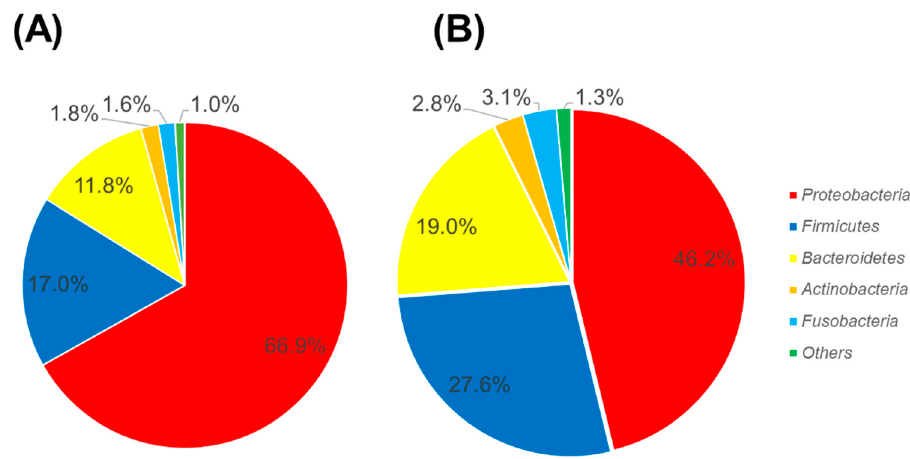
Figure 3. Comparison of the oral bacterial composition of subjects with or without dental caries. ( A ) Subjects without dental caries, and ( B ) subjects with dental caries.